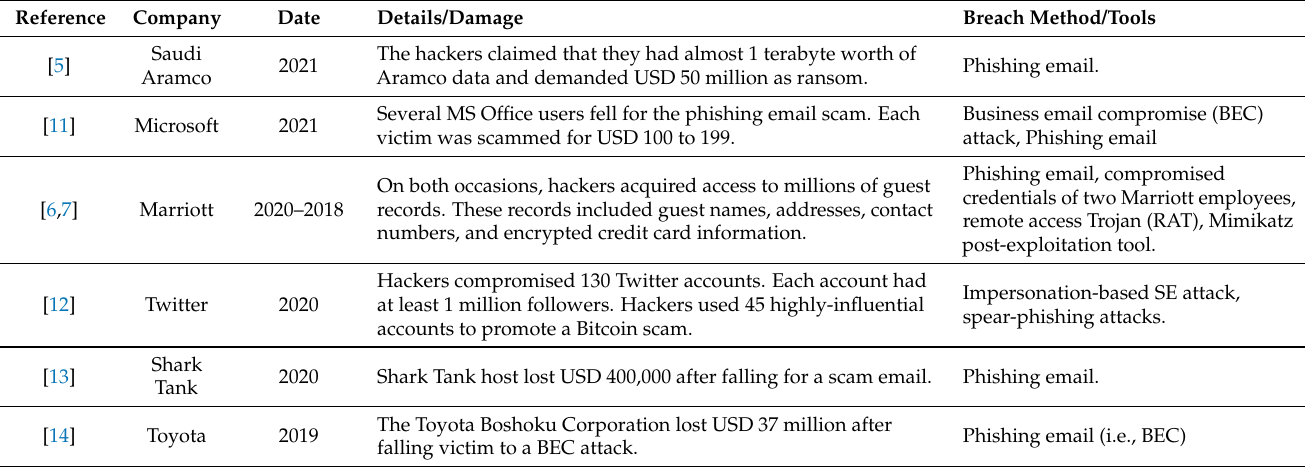
Table 1. Some of the most prominent social engineering-based